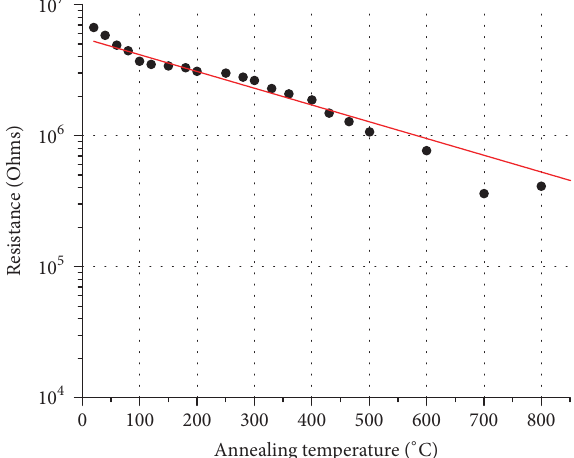
Figure 2: Resistance analysis of the TiN thin film as a function of postmetal annealing